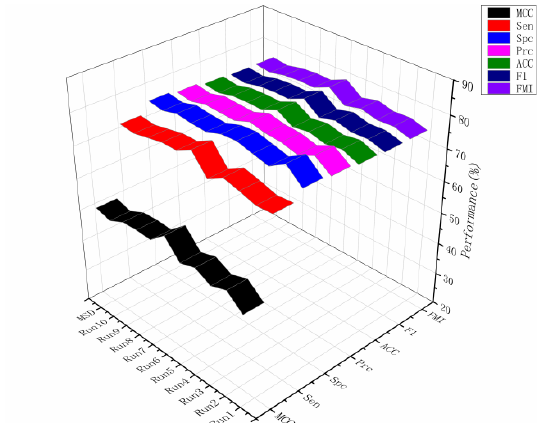
Fig 11 Model performance change trend